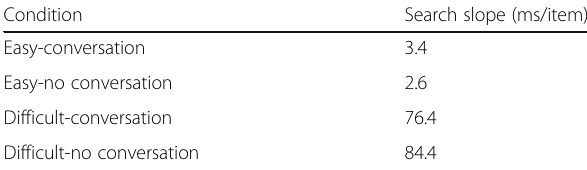
Table 1 Search slopes for each condition in experiment 2 Condition Search slope (ms/item)